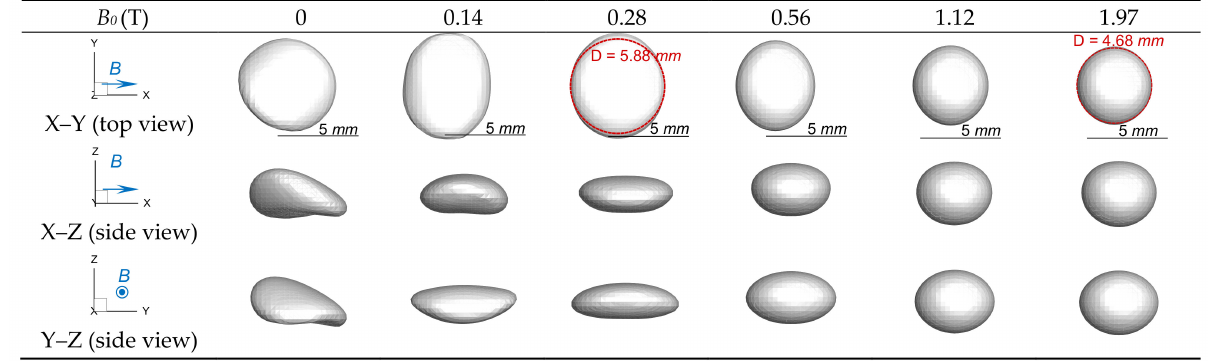
Figure 14. Calculated bubble shapes for different applied magnetic fields for Eo = 2.44. The snapshots were taken at t = 0.6 s for B 0 = 0 T, 0.14 T and 0.28 T, and at t = 0.4 s for B 0 = 0.56 T, 1.12 T and 1.97 T. The bubble shapes for B 0 ≥ 0.56 T are all steady in time, and the bubble approaches a more spherical shape as the magnetic field increases from 0.28 T to 1.97 T.